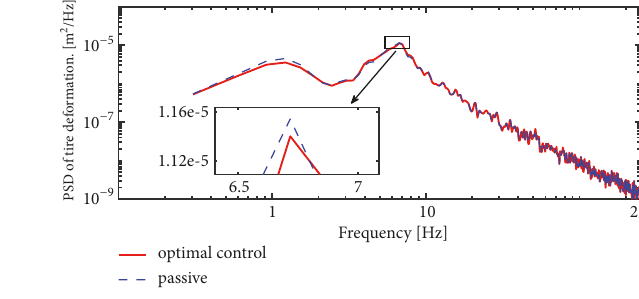
Figure 9: Frequency response of tyre deformation.